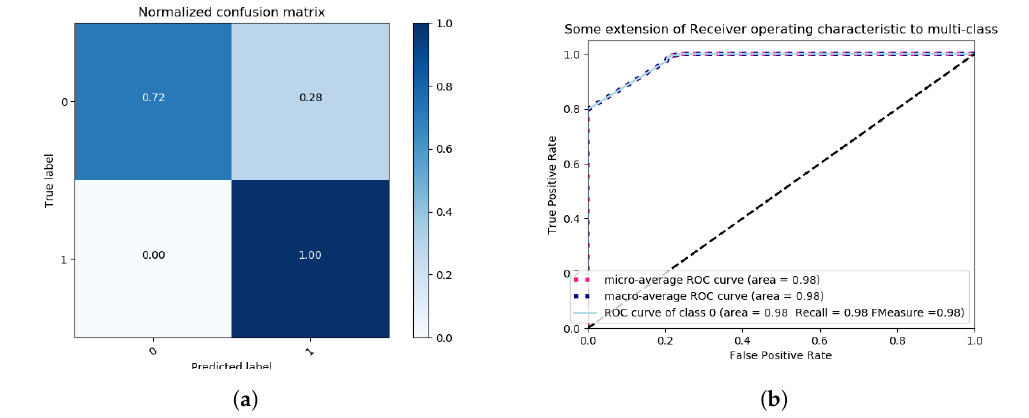
Figure 9. Binary class problem—Grid Search SVM with polynomial Kernel, One vs. Rest decision function shape, 30 iterations, with scoring criterion of accuracy, confusion Matrix ( a ) and ROC Curves ( b ).